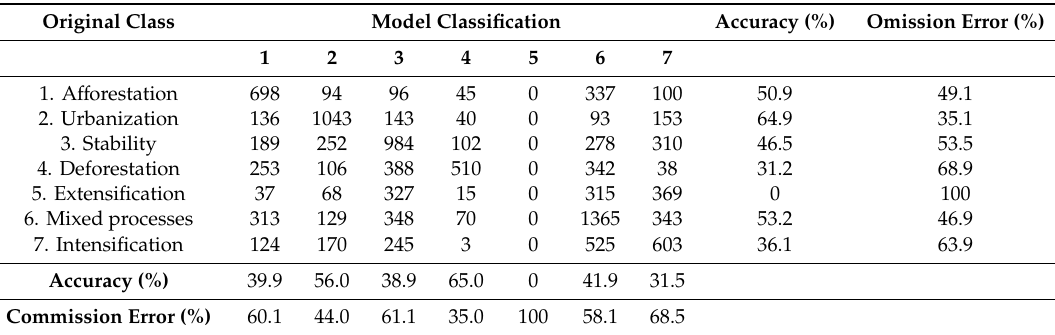
Table 2. Confusion matrix model